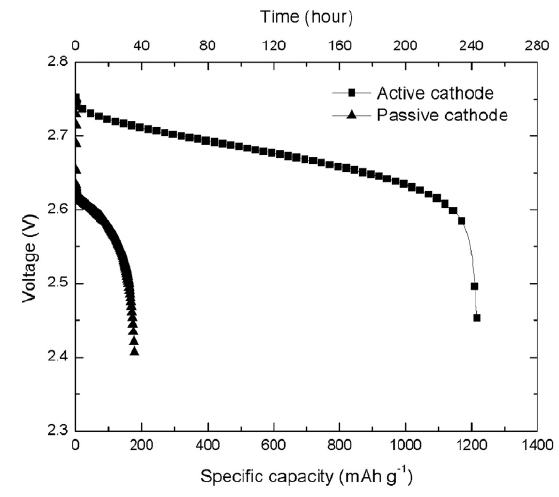
Figure 34. Comparison of voltage vs. specific capacity curves for Li-oxygen cells with passive and active cathodes. Here the discharge current density is 0.2 mA/cm 2 . Republished from Li et al. [46] with permission of The Electrochemical Society conveyed through Copyright Clearance Center, Inc.